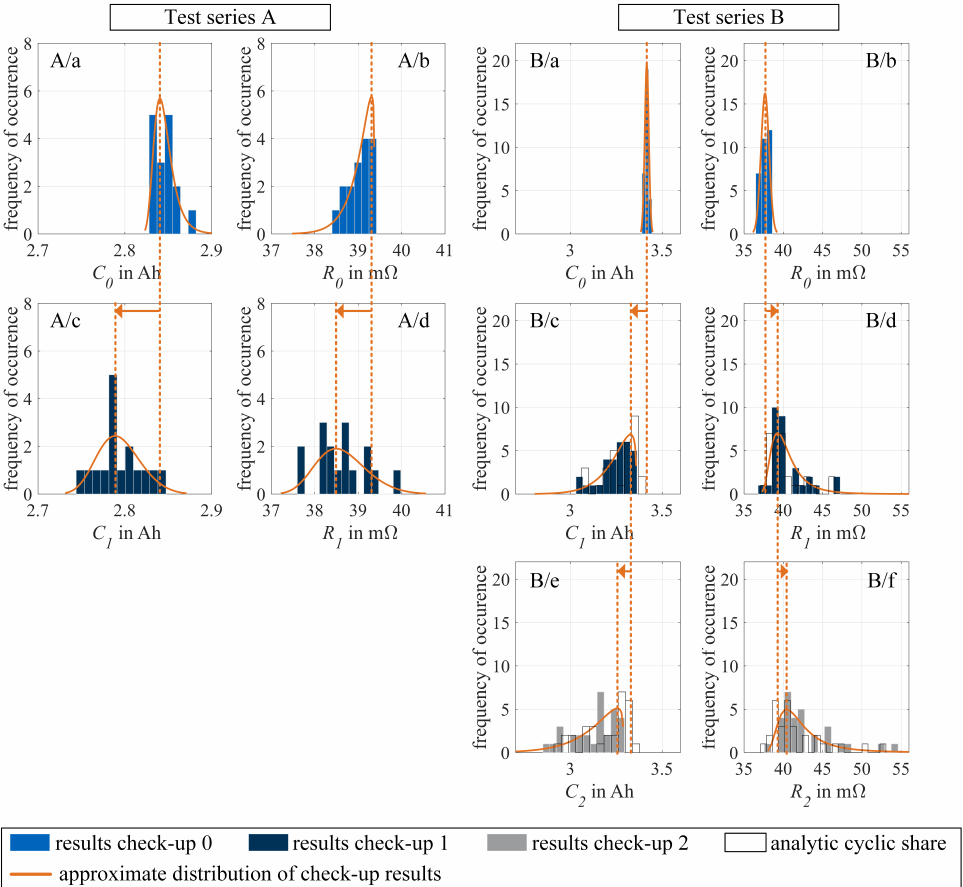
Figure 5. Check-up results for test series A and B: The filled bars show the measured values at check-up 0, check-up 1 (after 100 Ah for test series A, 350 Ah for test series B), and check-up 2 (not performed in test series A, after 700 Ah for test series B). The related approximate distributions illustrate the average changes as well as the increasing spreading of the cell characteristics along the aging process. The non-filled bars show the analytically calculated shares of cyclic aging for test series